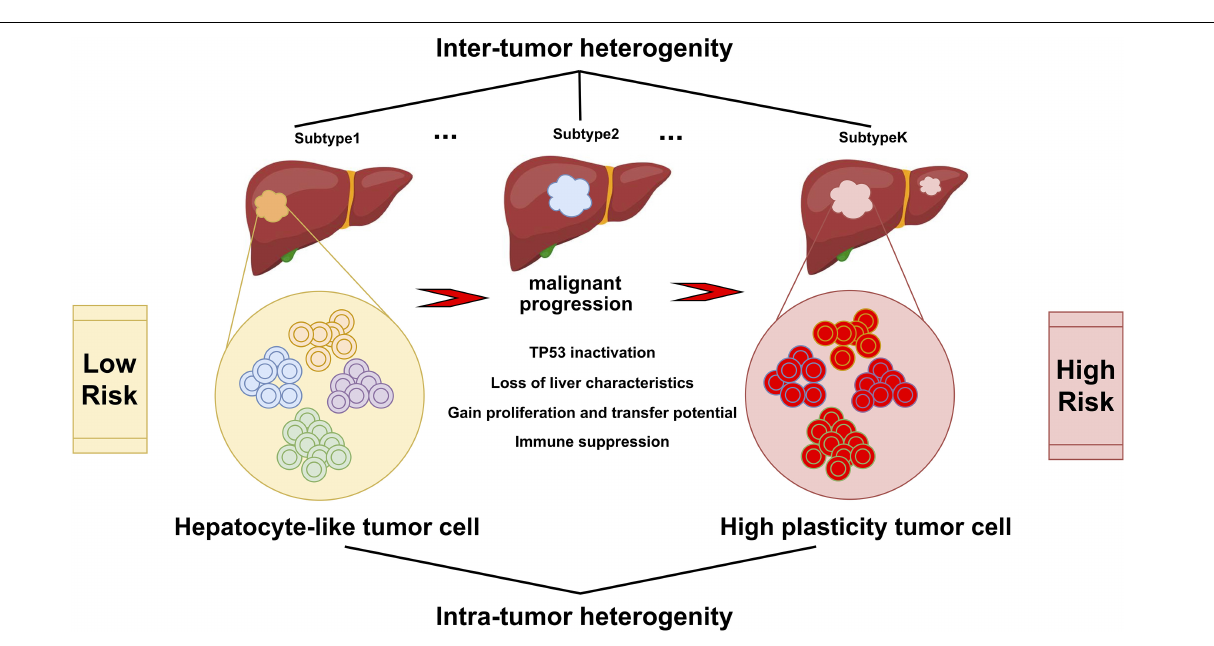
FIGURE 8 | Varied malignant cell subgroups contribute to the inter-tumor and intra-tumor heterogeneity of HCC. Hepatocyte-like tumor cells could progress to high plasticity tumor cells, accompanied by the inactivation of tumor suppressor pathways such as TP53, the disappearance of the inherent characteristics of hepatocytes, the enhancement of proliferation, invasion and metastasis ability, and the appearance of immune